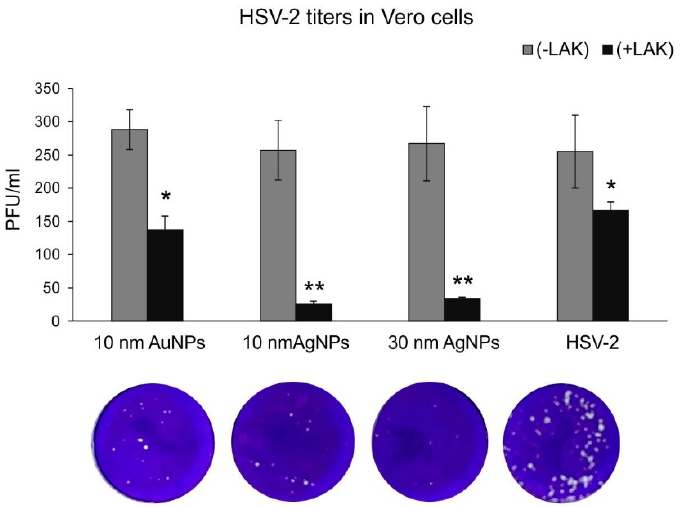
Figure 2. Inactivation of HSV-2 infection by lactoferrin-modified AgNPs or AuNPs in Vero cells is metal-related. HSV-2 titers (PFU/mL) in Vero cells infected with HSV-2 pre-incubated for 1 h with 10 nm AuNPs or AgNPs and 30 nm AgNPs modified or unmodified with lactoferrin. The data are expressed as means from three independent experiments ± SEM. * represents significant differences with p ≤ 0.05, ** p ≤ 0.001 in comparison to infected control (Student t test). Lower panel shows photos of crystal violet stained wells corresponding to graphs.